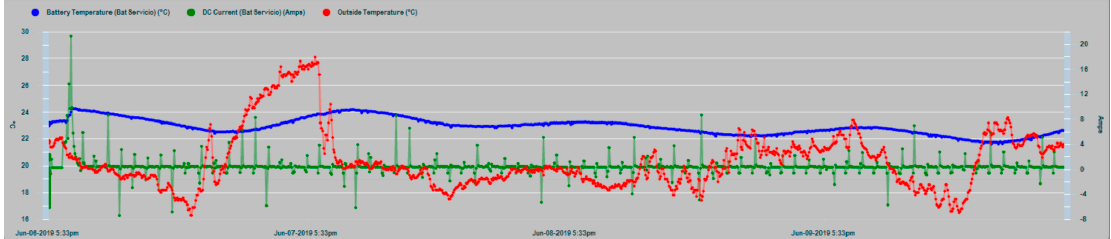
Figure 20. Peaks of energy demand versus temperature increases.